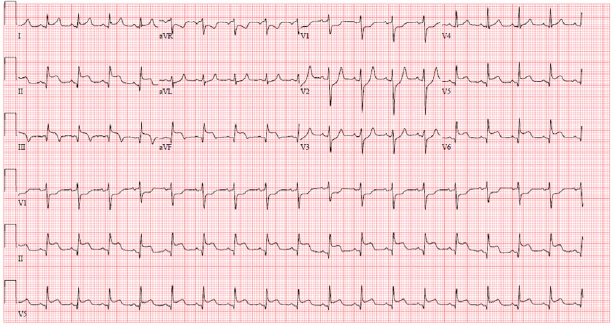
Figure 1: Inferolateral STEMI. ECG in the ED showing sinus tachycardia and ST-segment elevation in the inferolateral leads.